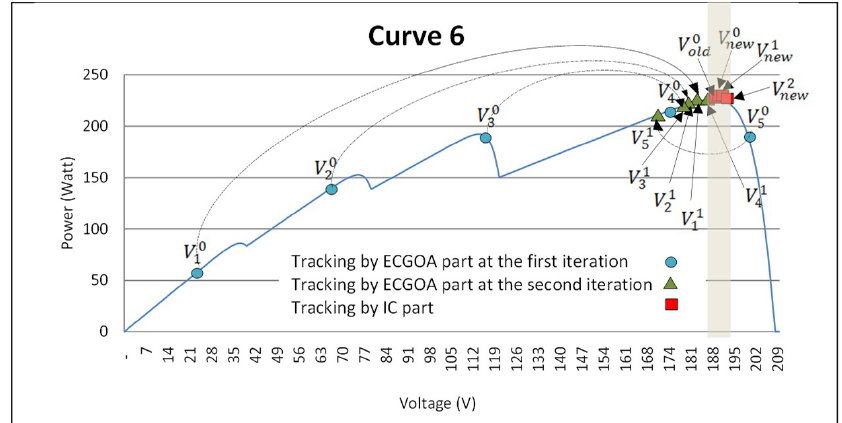
Figure 7. Tracking process example of the proposed method.